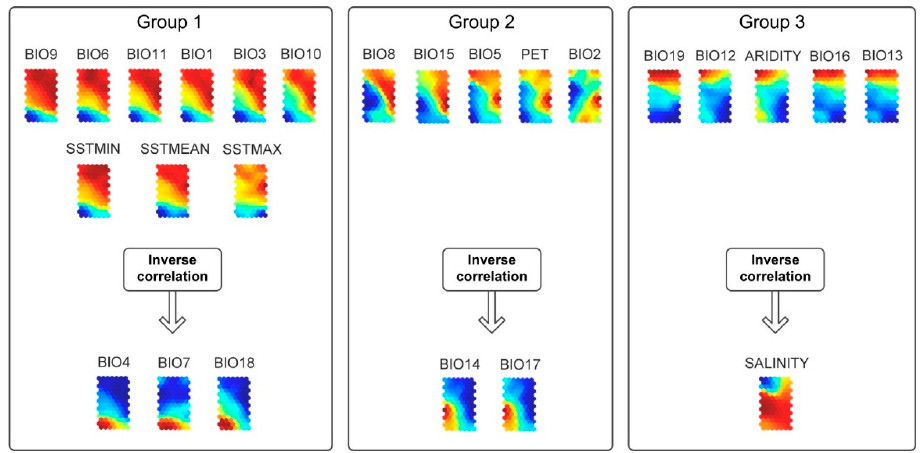
Figure 3. SOM Component planes. The component planes organized in three groups according to correlated components. High values are in red, intermediated values in yellow and green, and low values in dark blue.